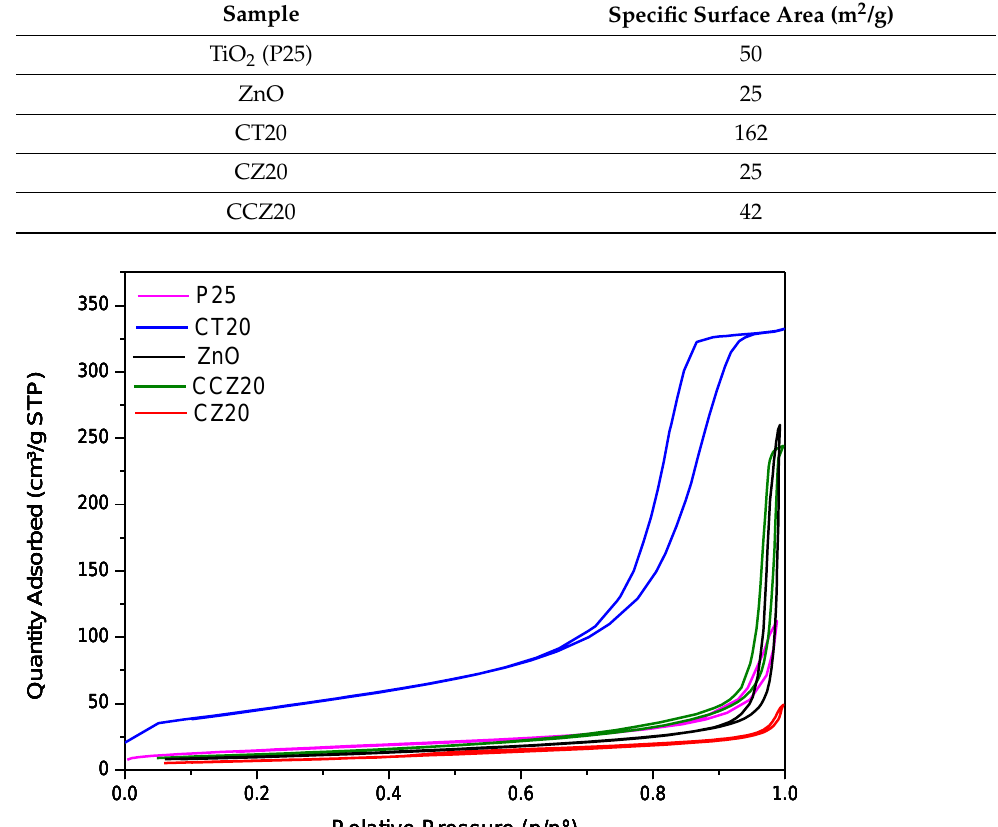
Table 1. BET-specific surface area of bare and CeO 2 -doped samples. Sample